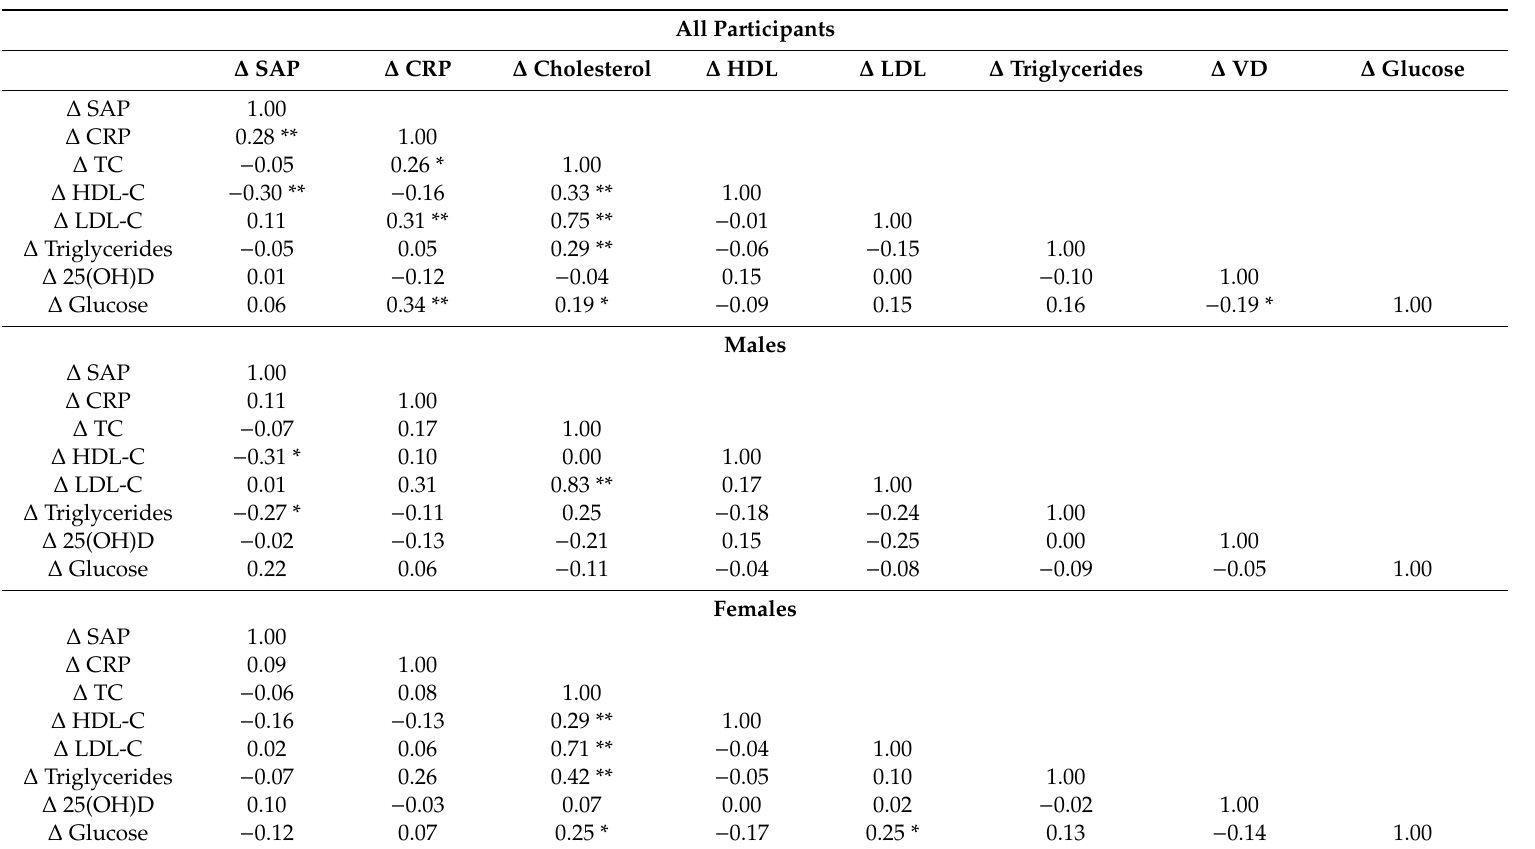
Table 5. Delta change associations between study parameters among